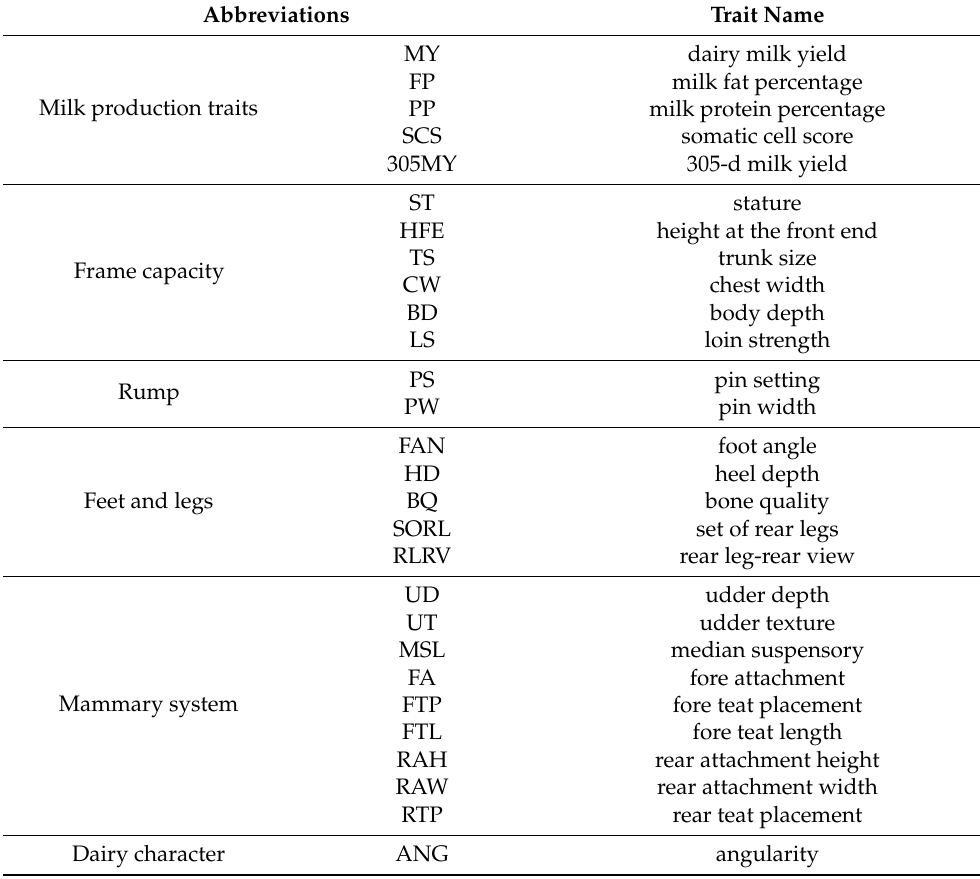
Table 1. Abbreviations and trait